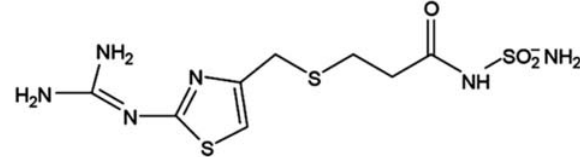
Figure 2b: Famotidine acid degradate (impurity C)